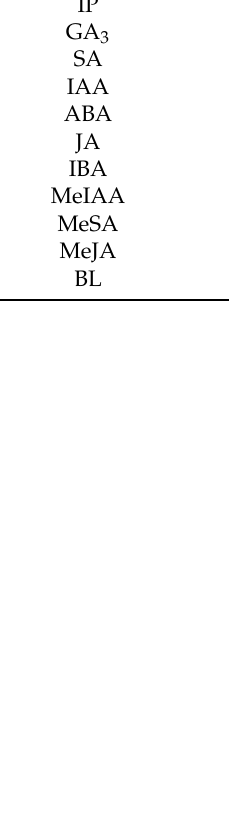
Table 3. Recoveries and precisions (coefficient of variation) of 11 phytohormones (%, n = 3). Phytohormones